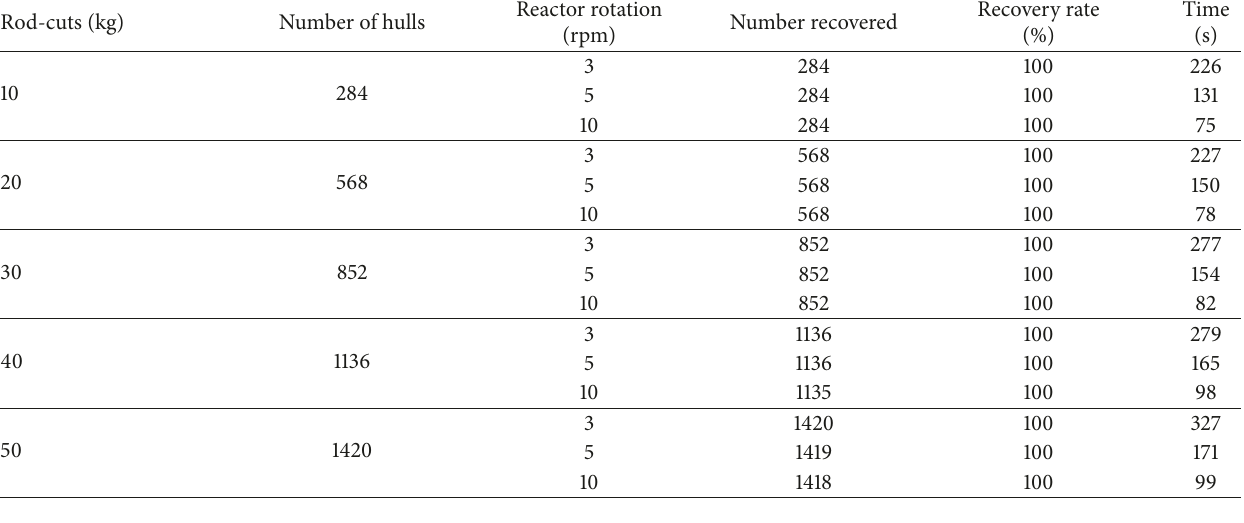
Table 2: Hull recovery ratios.